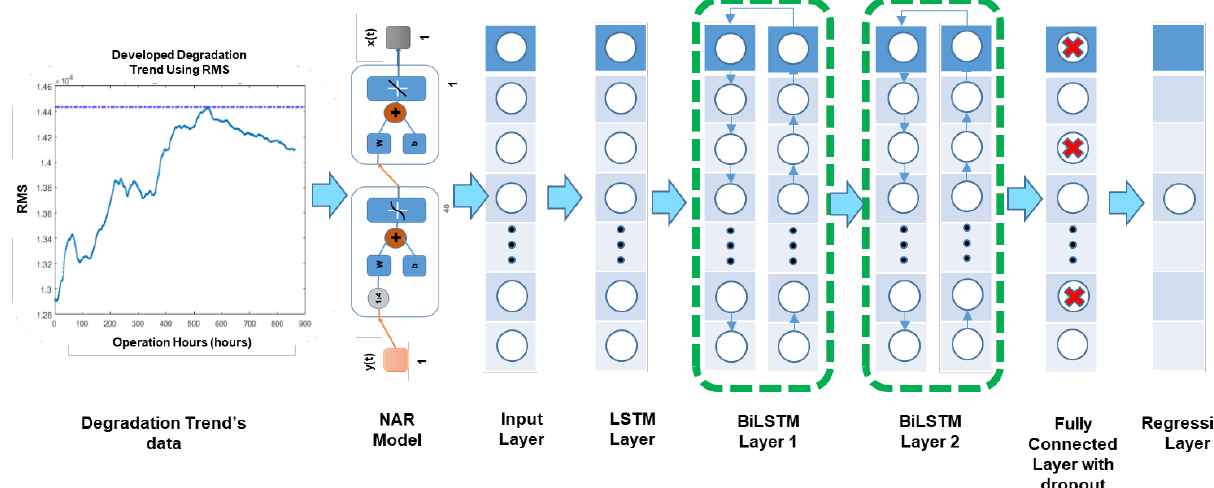
Figure 5. An illustrative diagram showing the overall architecture and data flow of the developed hybrid NAR-LSTM- BiLSTM model.